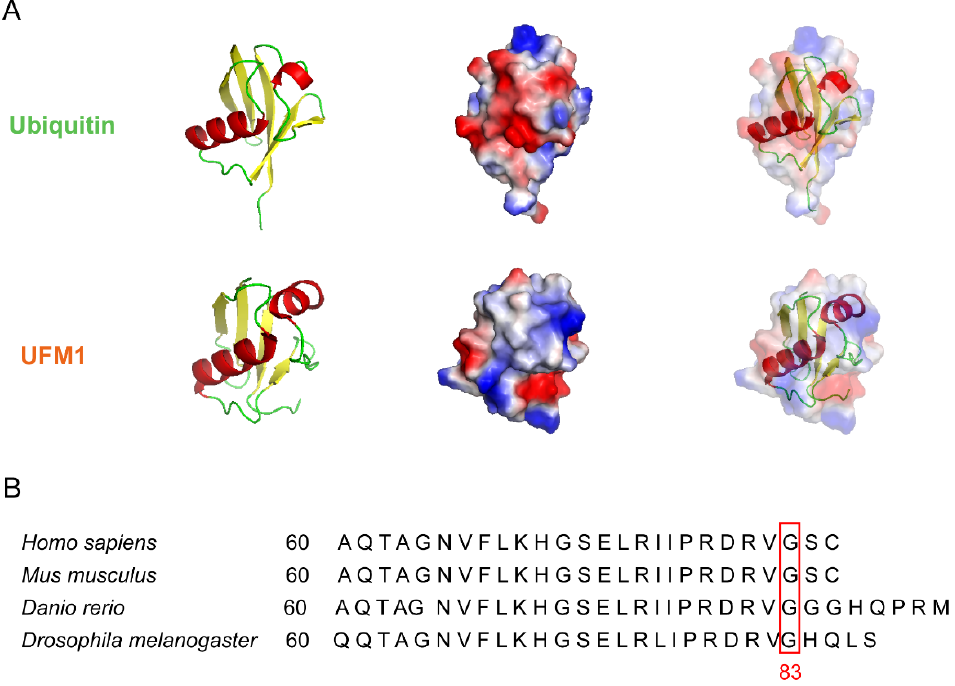
Figure 1. Structure and sequence alignment of UFM1. ( A ) Comparison between 3D structures and the electrostatic potential surfaces of ubiquitin-fold modifier 1 (UFM1) and ubiquitin (Ub). PDB IDs for ubiquitin and UFM1 are 1UBQ and 5IA7, respectively. Left panel—3D structure, α -helices and β -strands are shown in red and yellow, respectively. Middle panel-electrostatic potential surface, positive and negative potentials are shown in blue and red, respectively. Right panel—the merged image. ( B ) Sequence alignment of UFM1 in different species. The 83 amino acid residue in all species is indicated by red box.